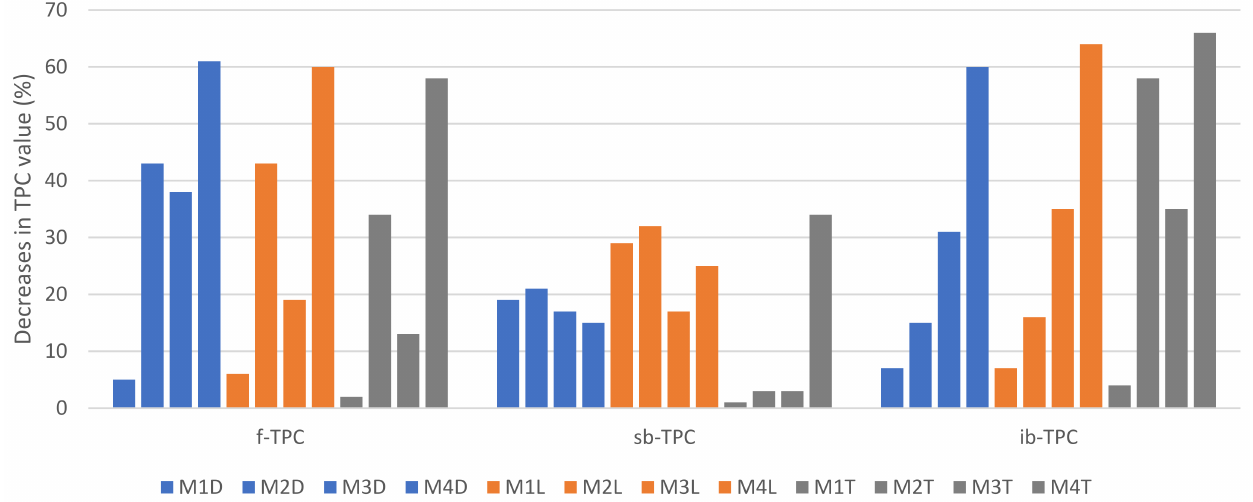
Figure 2. Percentage decreases in TPC concentrations for individual phenolic fractions of the M1–M4 nutraceutical mixtures under the defined storage conditions: f-TPC (free phenolics), sb-TPC (soluble bound phenolics), ib-TPC (insoluble bound phenolics), D (storage without sunlight, blue color),